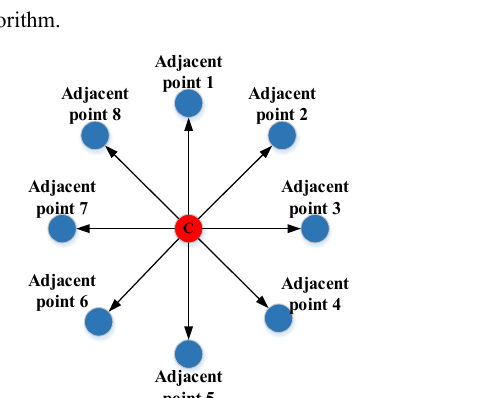
Fig. 3. Diagram of the A* algorithm.